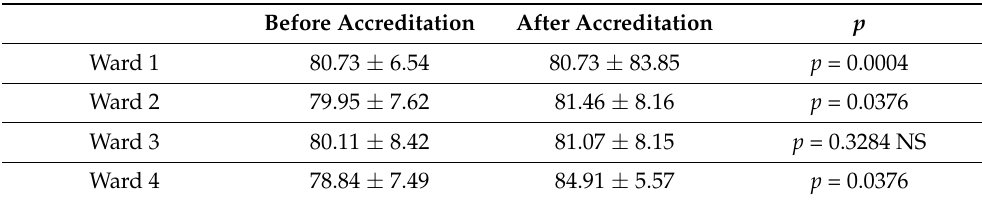
Table 2. Selected descriptive statistics, the number of points for the total assessment before vs. after accreditation for the analyzed departments.